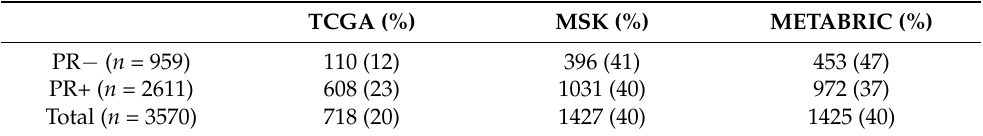
Table 1. Number ER+ breast cancer samples, according to the PR status from the TCGA, MSK, and METABRIC projects. PR, progesterone